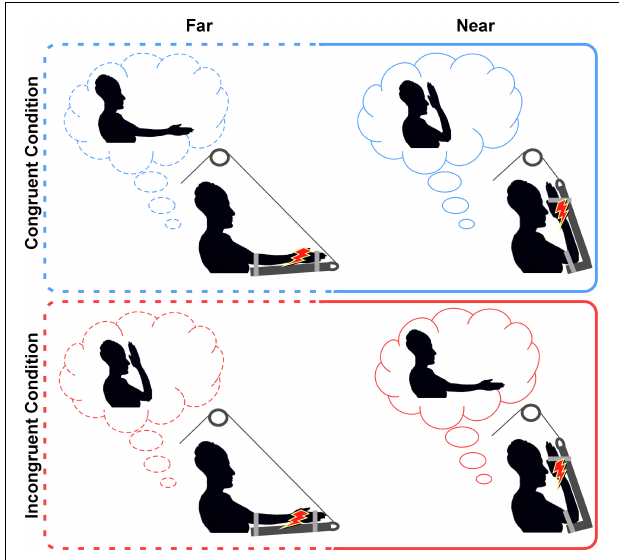
FIGURE 1 | Experimental conditions. In both congruent and incongruent conditions, the P+ patient was asked to voluntary reach either far or near positions (requested positions in the light-blue and red clouds). Once the patient reached the requested position, he had to relieve the arm’s weight on the supporting device and wait for the stimulus. Note that in congruent conditions ( top panel ), the intended position and the actual position of the hand were the same, while, in the incongruent conditions ( bottom panel ) they were the opposite. Indeed, before the stimulus was delivered, the co-experimenter activated the pulley to move the patient’s arm in the opposite position. The red lightning represents the electrical stimulation delivered to the median